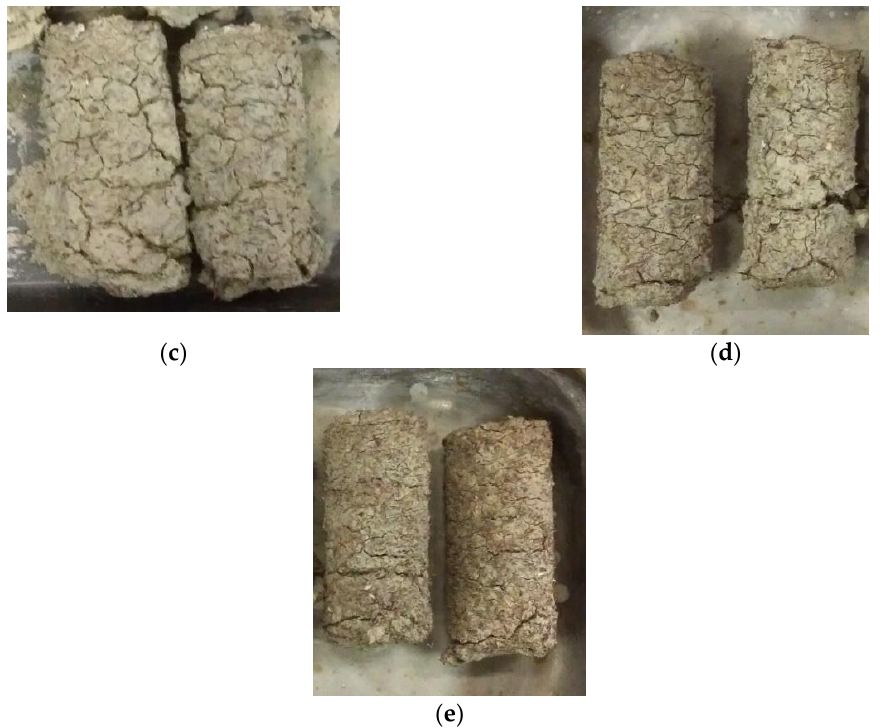
Figure 3. Cured mixture (7 days) of the bentonite-slag-cement ( a ) 0%, ( b ) 3%, ( c ) 5%, ( d ) 10% and ( e ) 15% after sulphate attack.